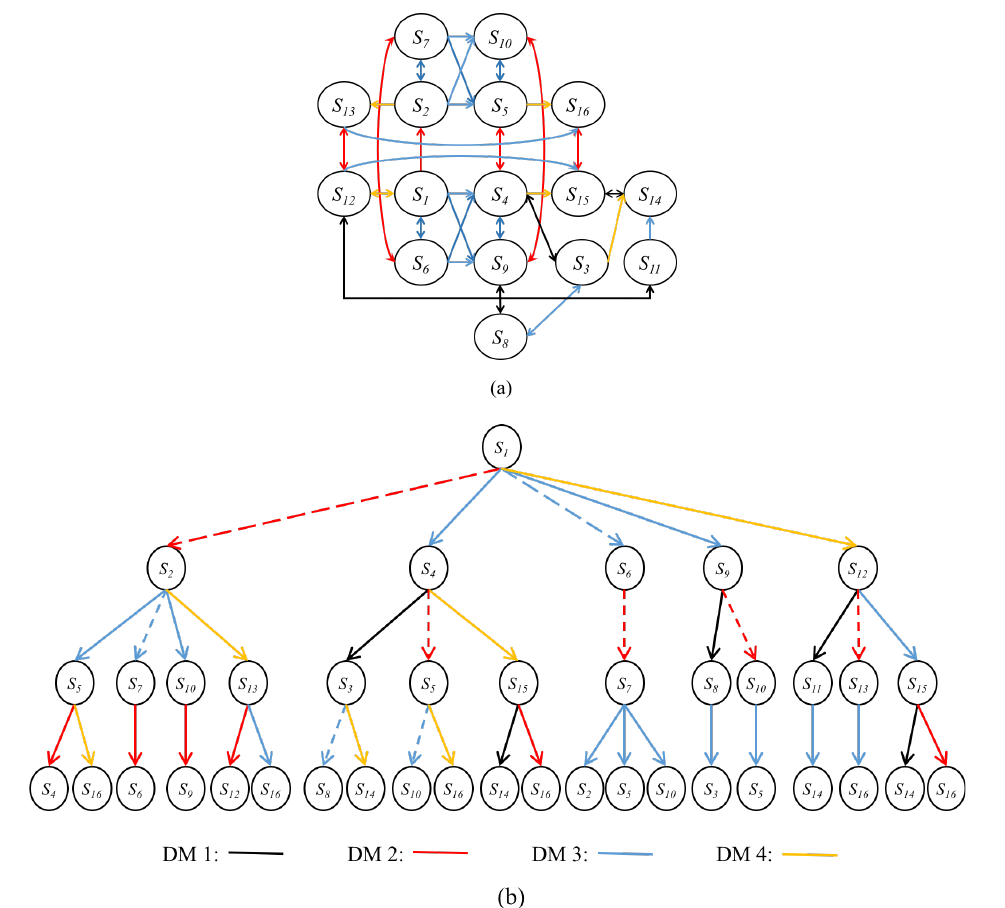
Figure 10. Graph model for the Changzhou conflict. ( a ) corresponding integrated graph; ( b ) three-step tree graph beginning from the status quo